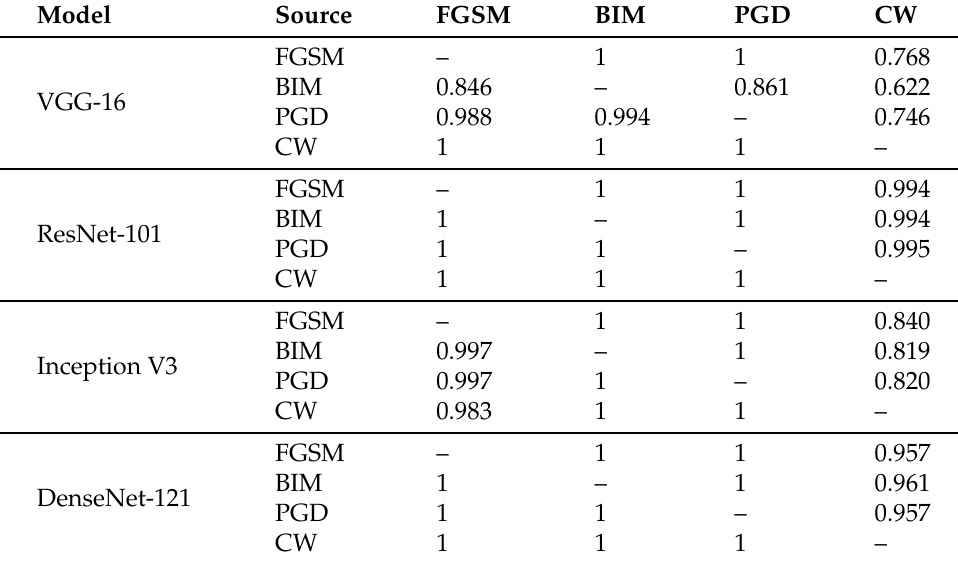
Table 5. Results of detection model transferability for 2-class DNN models.